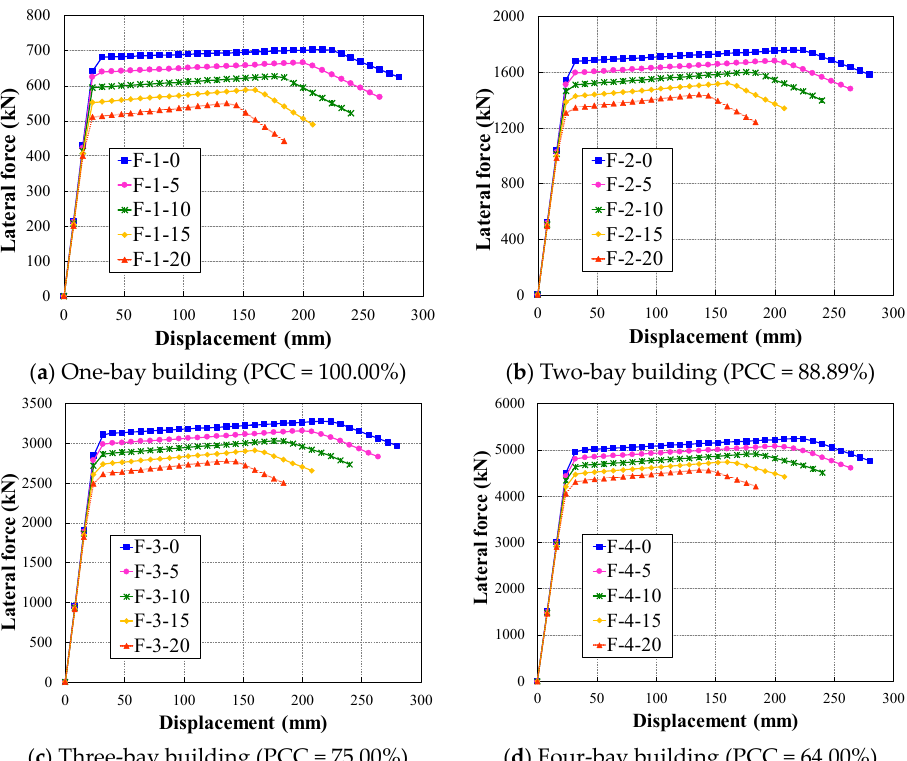
Figure 9. First story backbone curves of all cases: ( a ) One-bay building (PCC = 100.00%); ( b ) Two-bay building (PCC = 88.89%); ( c ) Three-bay building (PCC = 75.00%); ( d ) Four-bay building (PCC = 64.00%). [18] can be adjusted using Equations (16)–(19) (Figure 3).